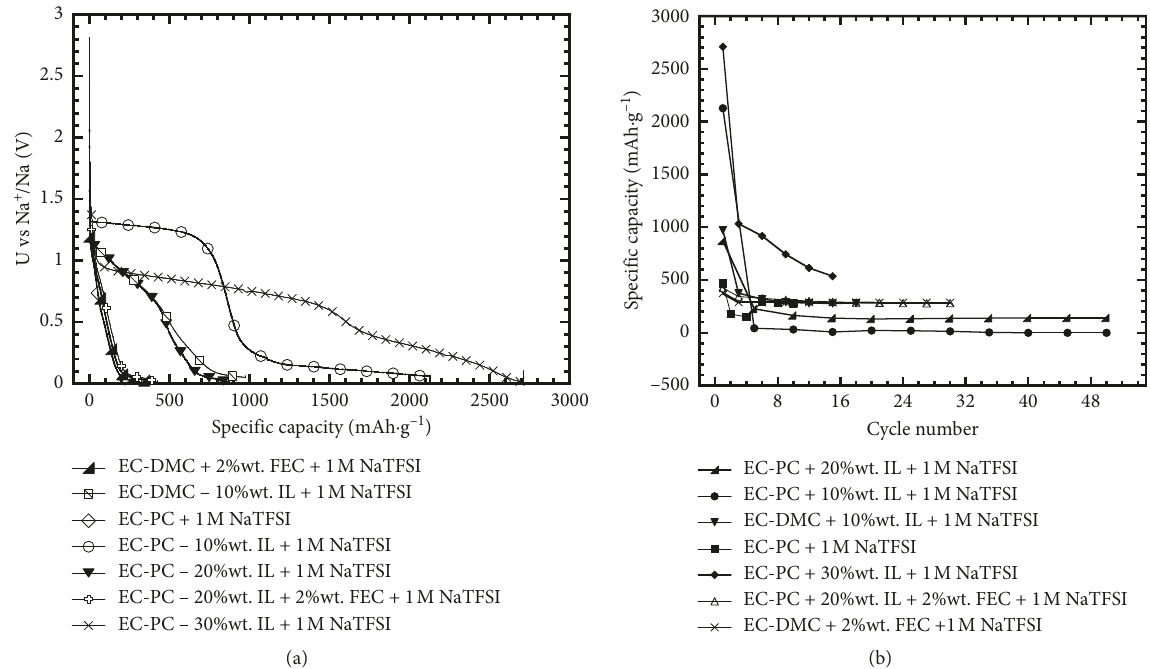
Figure 6: (a) 1 st discharge capacity of half-cell ( − ) Na | EC-PC (1:1)+ x wt.% EMI-TFSI+1M NaTFSI | hard carbon and (b) cycling discharge capacity as a function of cycle number at C/10 electrolyte (EC-PC). The highest discharge capacity of mixed electrolyte using 20 wt.% EMI-TFSI as co-solvent. In 92 mAh · g − 1 was obtained for the mixed electrolyte EC-PC Figure 7, the half-cell using electrolytes based on EMI-TFSI exhibited as stable performance as carbonate-based (1 :1) + 20 wt.% EMI-TFSI + 2 wt.% FEC + 1 M NaTFSI.